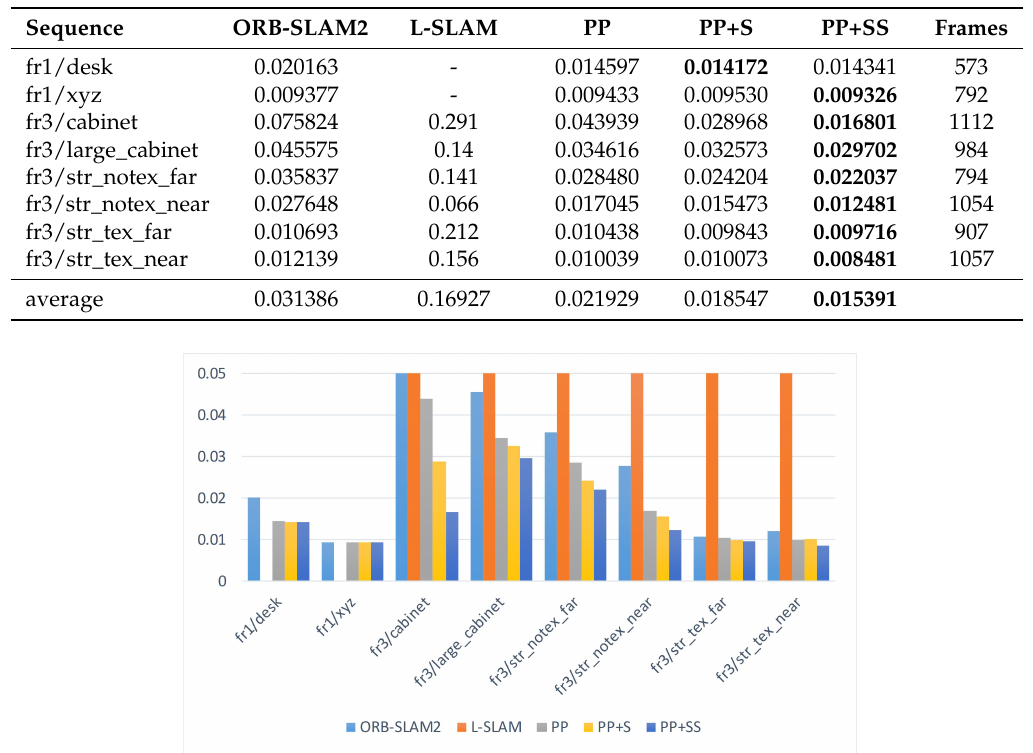
Table 3. Evaluation results of translation ATE RMSE (unit: m) on TUM RGB-D dataset. PP, PP+S, PP+SS denote proposed point-plane SLAM, point-plane SLAM using structural constraints, point-plane SLAM using structural constraints and supposed planes, respectively. Bold numbers represent the best performances.